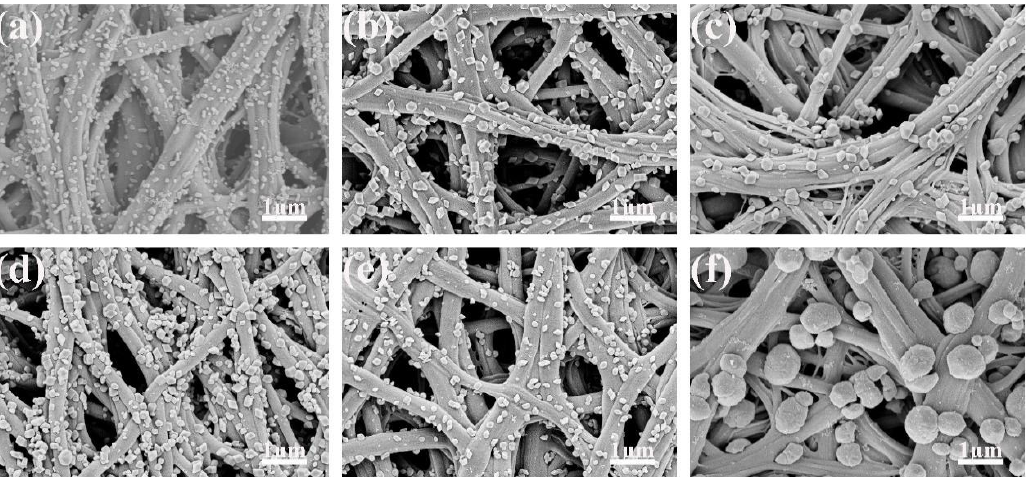
Figure 3. SEM images of Fe 2 O 3 /CNFs (effect of time): ( a ) 1 h; ( b ) 2 h; ( c ) 3 h; ( d ) 4 h; ( e ) 5 h; ( f ) 6 h.